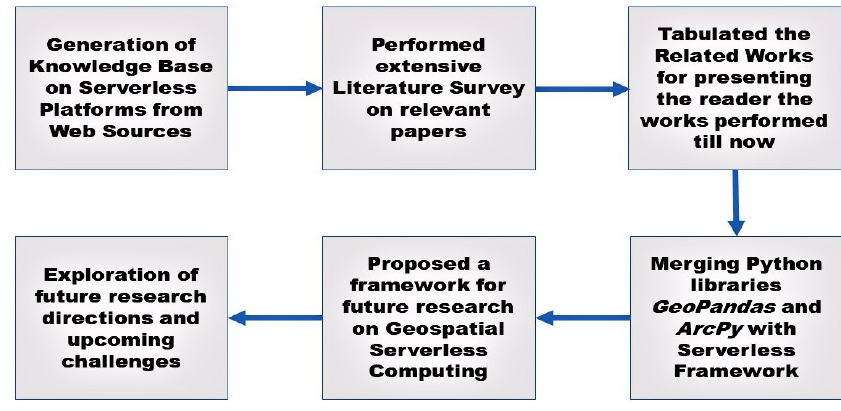
Figure 2. Visual representation of the research methodology behind our research